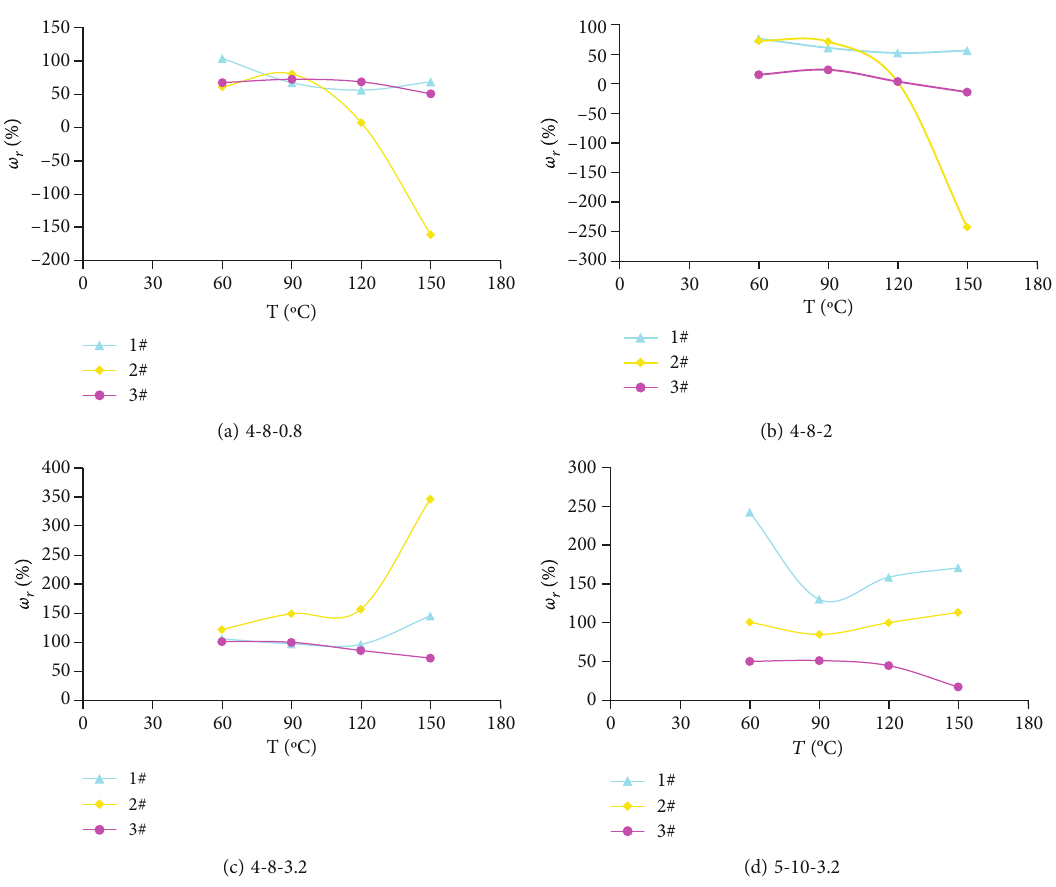
Figure 8: Relationship between ω